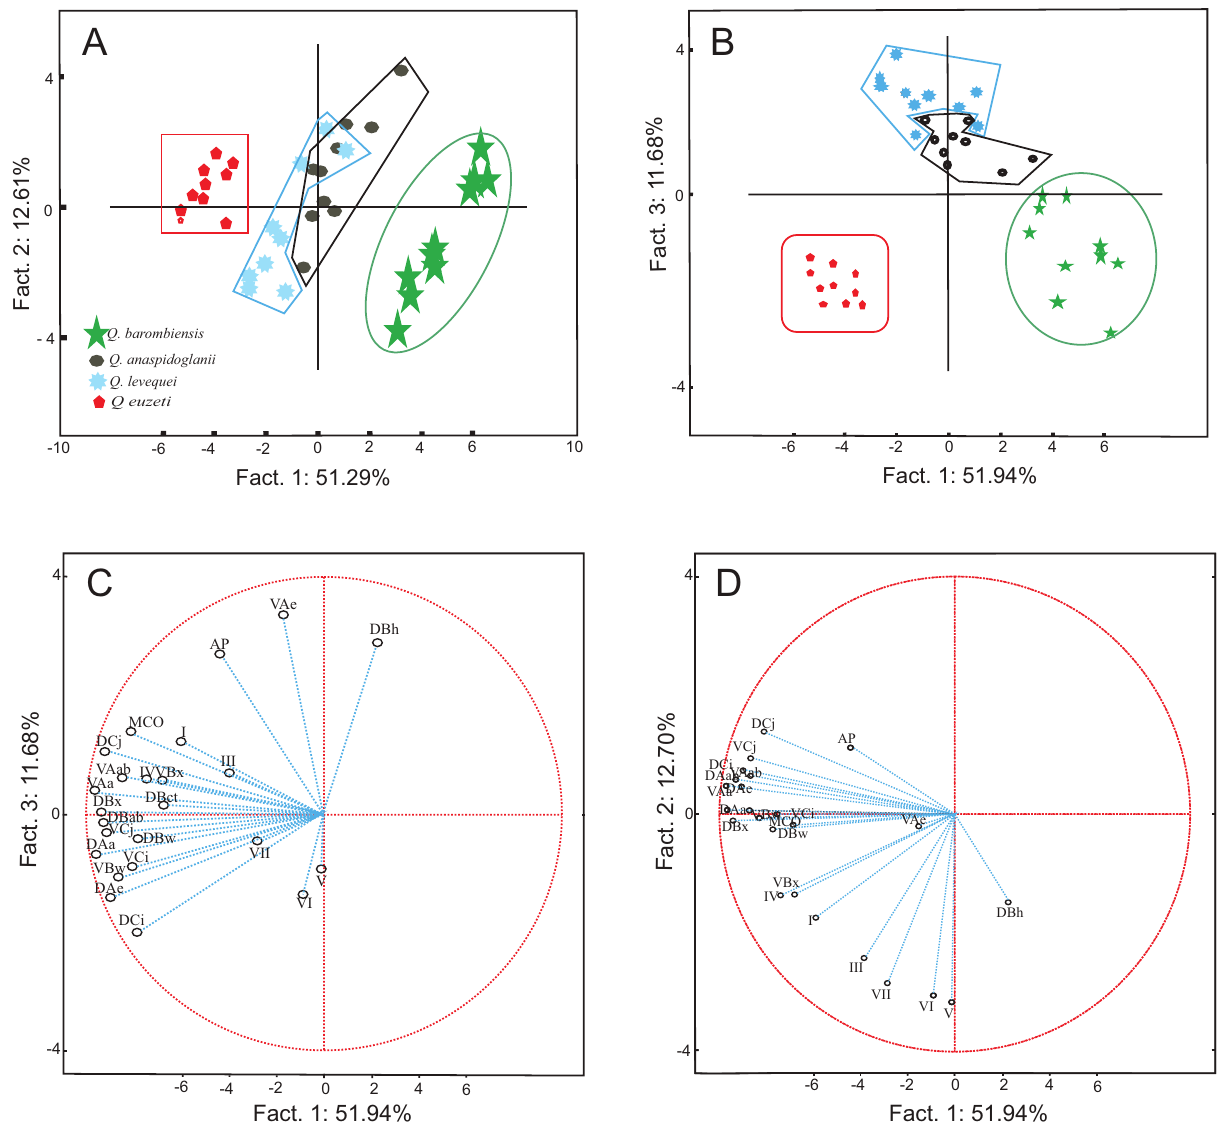
Figure 5. Principal component analysis scatterplot of 10 Quadriacanthus specimens of each of the following species: Quadriacanthus euzeti from Papyrocranus afer , Quadriacanthus barombiensis n. sp. from Clarias maclareni , Quadriacanthus anaspidoglanii from Anaspidoglanis macrostoma and Quadriacanthus levequei from Clarias jaensis . A: axes 1 and 2, B: axes 1 and 3. C and D: scatterplot of variable along axis 1 and 2 and axis 1 and 3, respectively. Dorsal anchor: (DA a ) length, (DA ab ) base width, (DA e ) point length. Ventral anchor: (VA a )